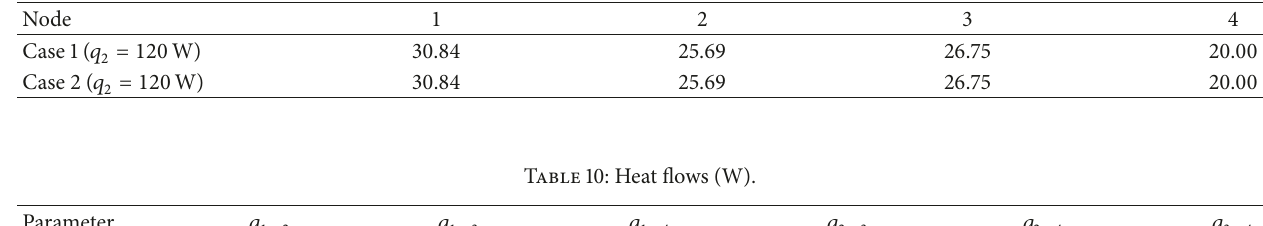
Table 9: Temperature results ( ∘ C).